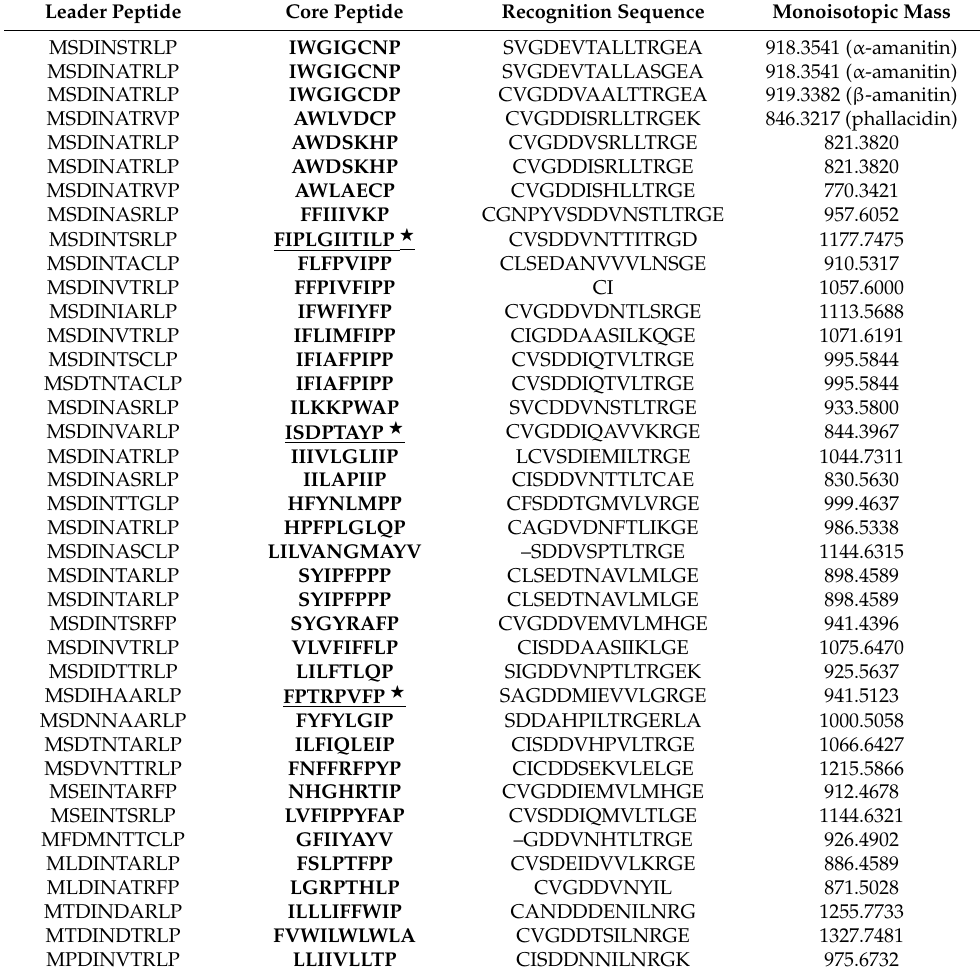
Table 1. The MSDIN gene family in Amanita